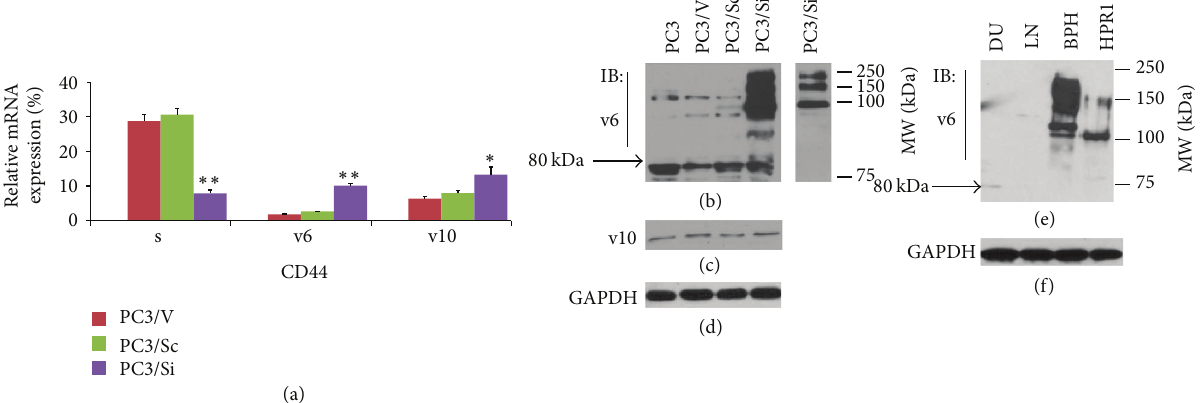
Figure 1: Determination of the expression of CD44s, v6, and v10 in PC3 cells knockdown of MMP9: PC3 cells transfected with vector DNA (PC3/V), scrambled nonsilencing SiRNA (PC3/Sc) and silencing SiRNA (PC3/Si) were used for real time PCR (a) and immunoblotting analyses (b–f). Untransfected PC3 cells were also used as controls. The expression levels of CD44s, CD44v6, and CD44v10 mRNA were determined by real time PCR analysis and normalized relative to GAPDH expression (a). ∗∗ 𝑃 < 0.001 ; ∗ 𝑃 < 0.01 versus indicated respective controls (PC3/V and PC3/Sc). Equal amount of protein was used for immunoblotting analysis with an antibody to CD44v6 (b and e) and CD44v10 (c). A shorter exposure blot for PC3/Si cells is shown in lane 5. The blot in (b) was stripped once and probed successively with an antibody to CD44v10 (c) and GAPDH (d). The blot in (e) was stripped and reprobed with an antibody to GAPDH. The levels of GAPDH represent the loading control for each experiment set. The results shown are representative of three or four